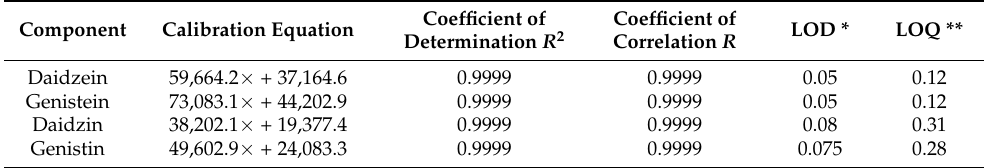
Table 3. The linearities of calibration curves of